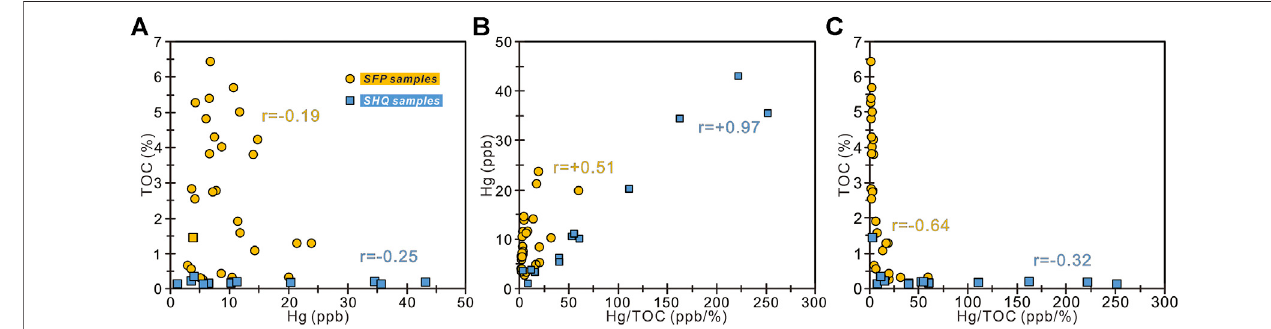
FIGURE 3 | Cross plot of (A) TOC vs. Hg, (B) Hg vs. Hg/TOC, and (C) TOC vs.